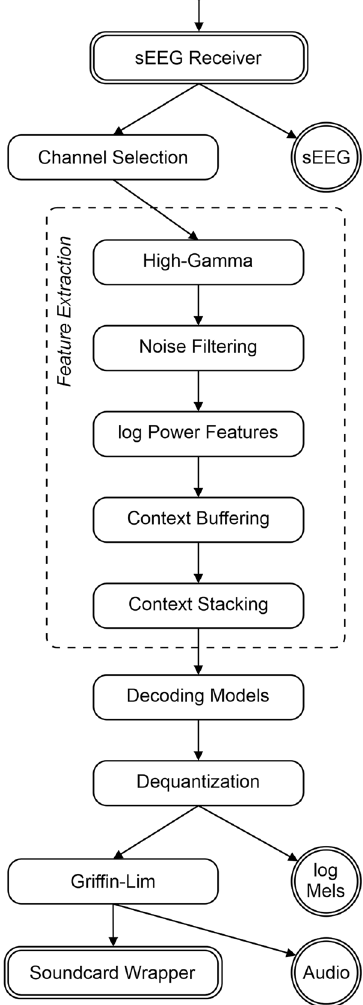
Fig. 6 Schematic overview of the proposed closed-loop decoder. Each node corresponds to one self-contained task, which is connected in an acyclic network. Rectangular nodes specify actual computations in the generation of the acoustic waveform, while circular nodes represent output nodes writing incoming data on disc for of fl ine evaluation. Double-lined nodes indicate that its (and subsequent) calculations are performed asynchronously in different processes. The extraction of neural activity is composed of multiple